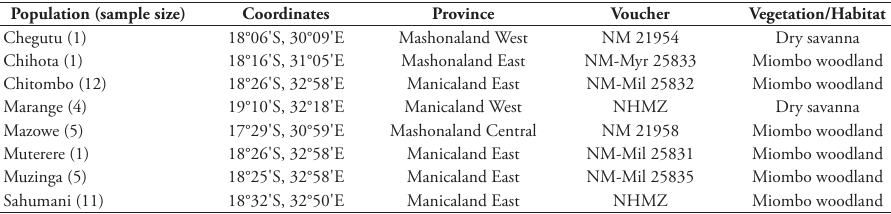
Table 1. Details of the B. flavicollis populations and samples. Population (sample